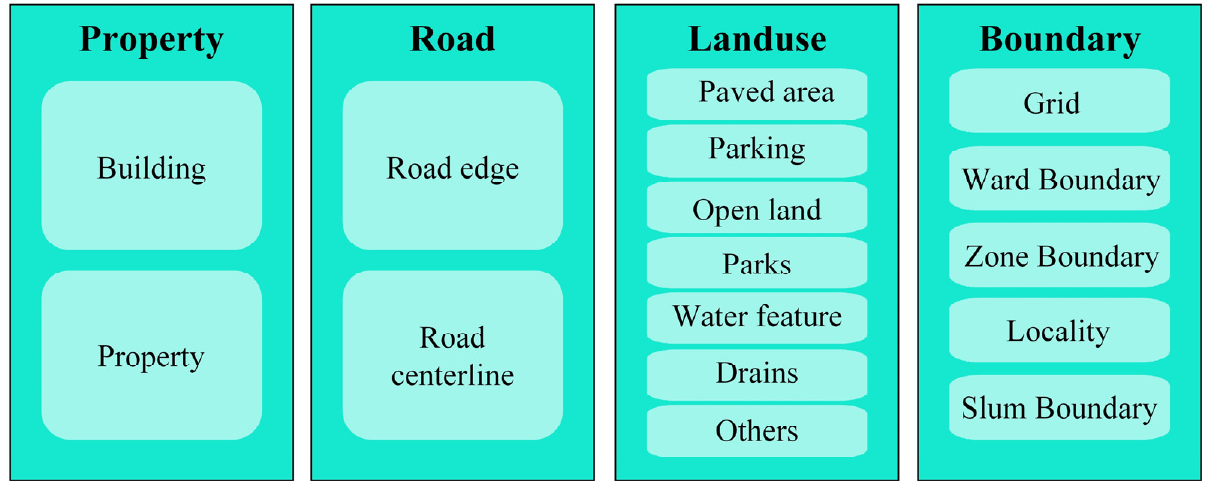
Figure 3. Geodatabase structure of the Hauz Khas ward (I).